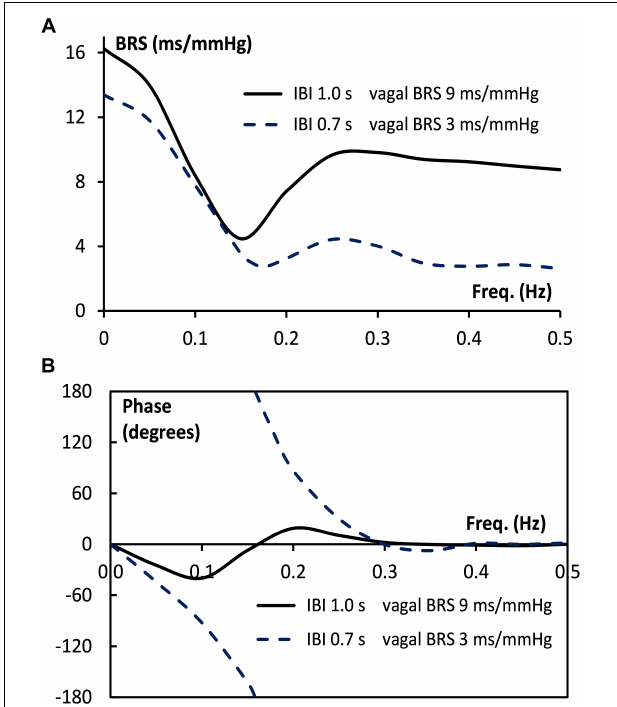
FIGURE 9 | Bode plot of BRS for simulated supine and HUT data. The size (A) and the phase angle (B) of the BRS vector are given as a function of frequency, both for the supine (drawn line) and the HUT conditions (dotted line).